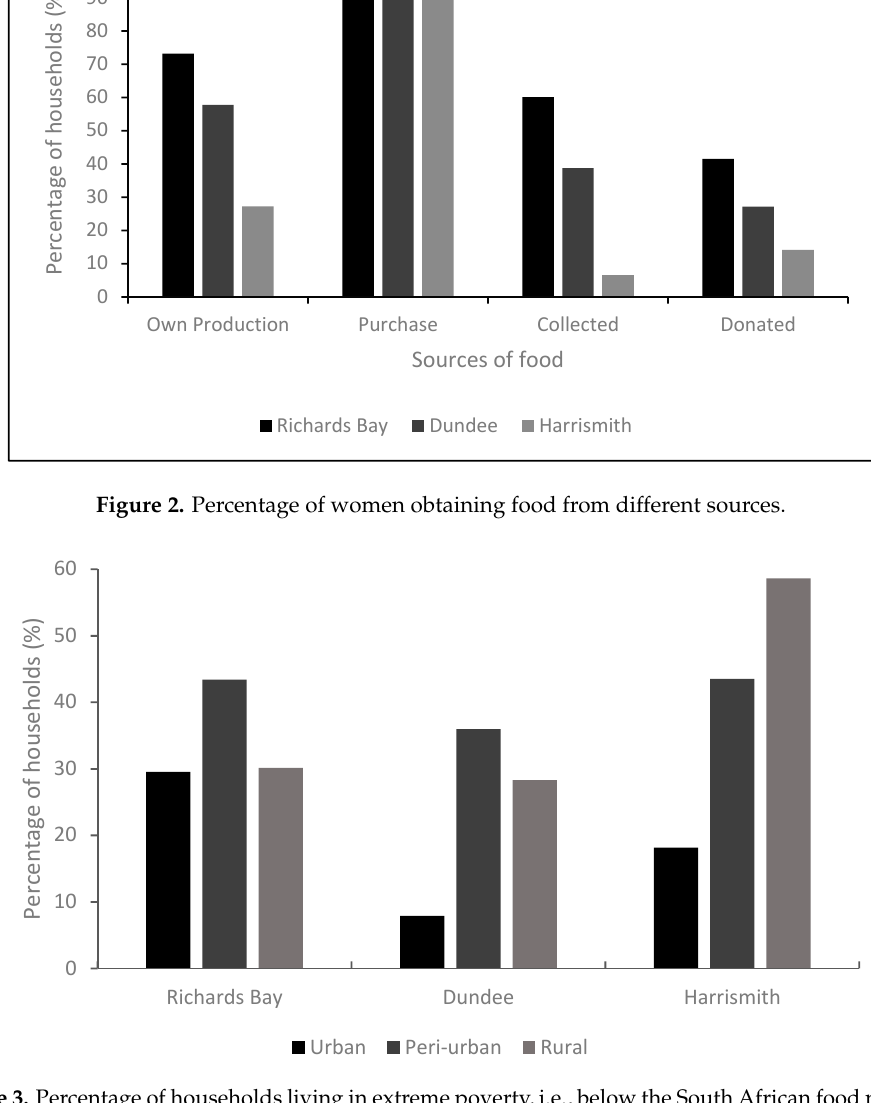
Figure 3. Percentage of households living in extreme poverty, i.e., below the South African food poverty line (FPL) of R321 per capita per month as per March 2011 [28].